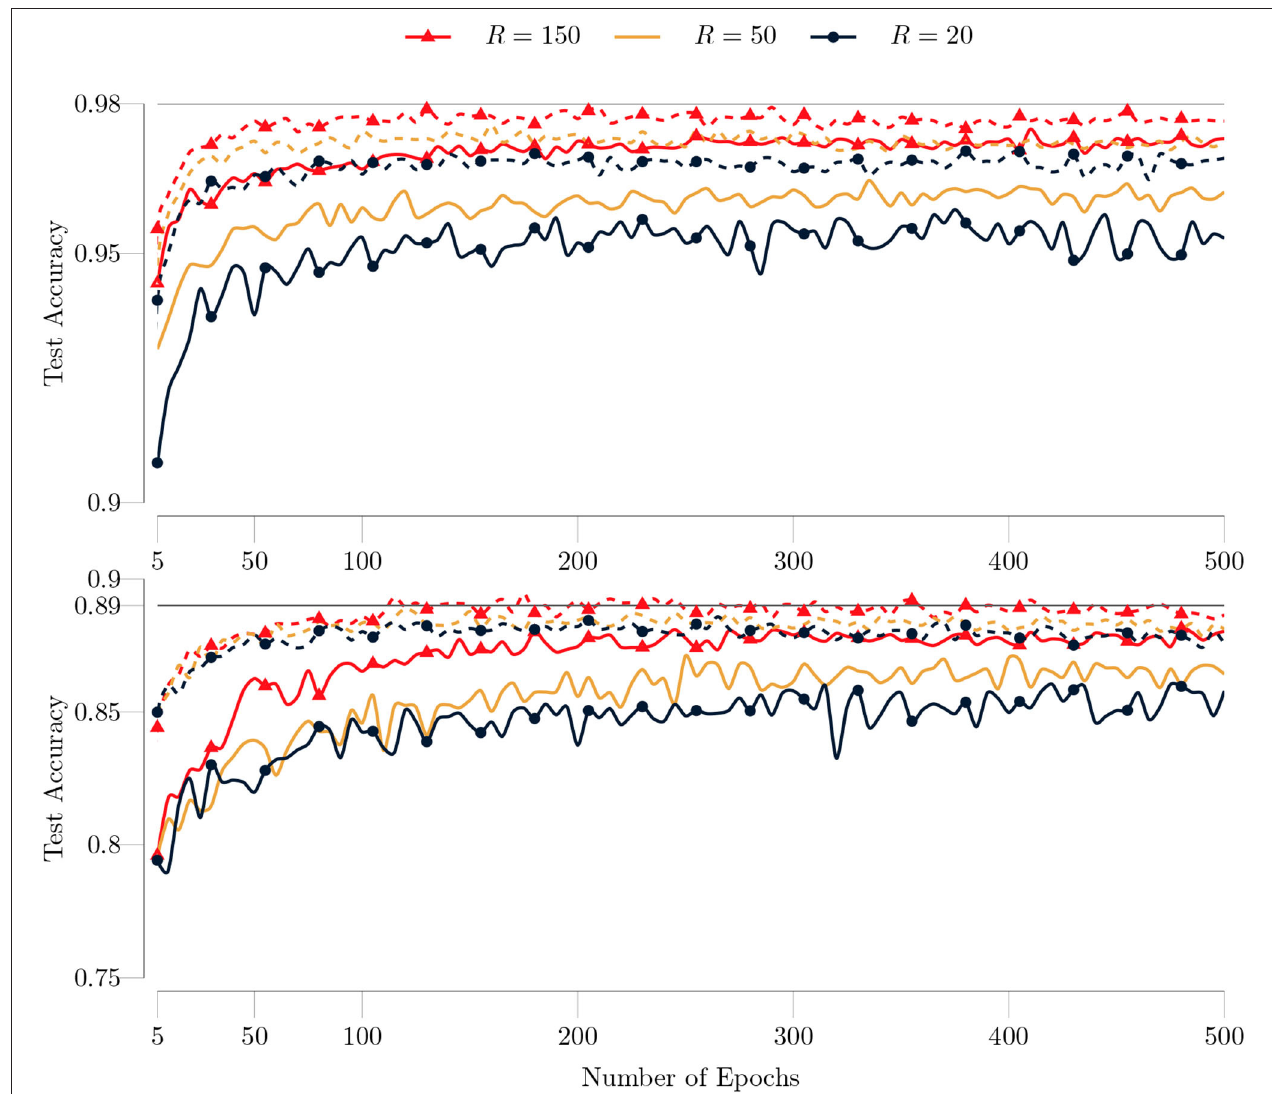
FIGURE 15 | Comparison of test accuracies of the type II model on the MNIST (top) and Fashion MNIST (bottom) datasets for different maximum number of GN iterations as a function of the number of epochs. The full training set (60,000 images) and test set (10,000 images) are used. The batch size is set to 200 and the maximum number of GN iterations is set to 1 (dashed lines) and to 5 (solid